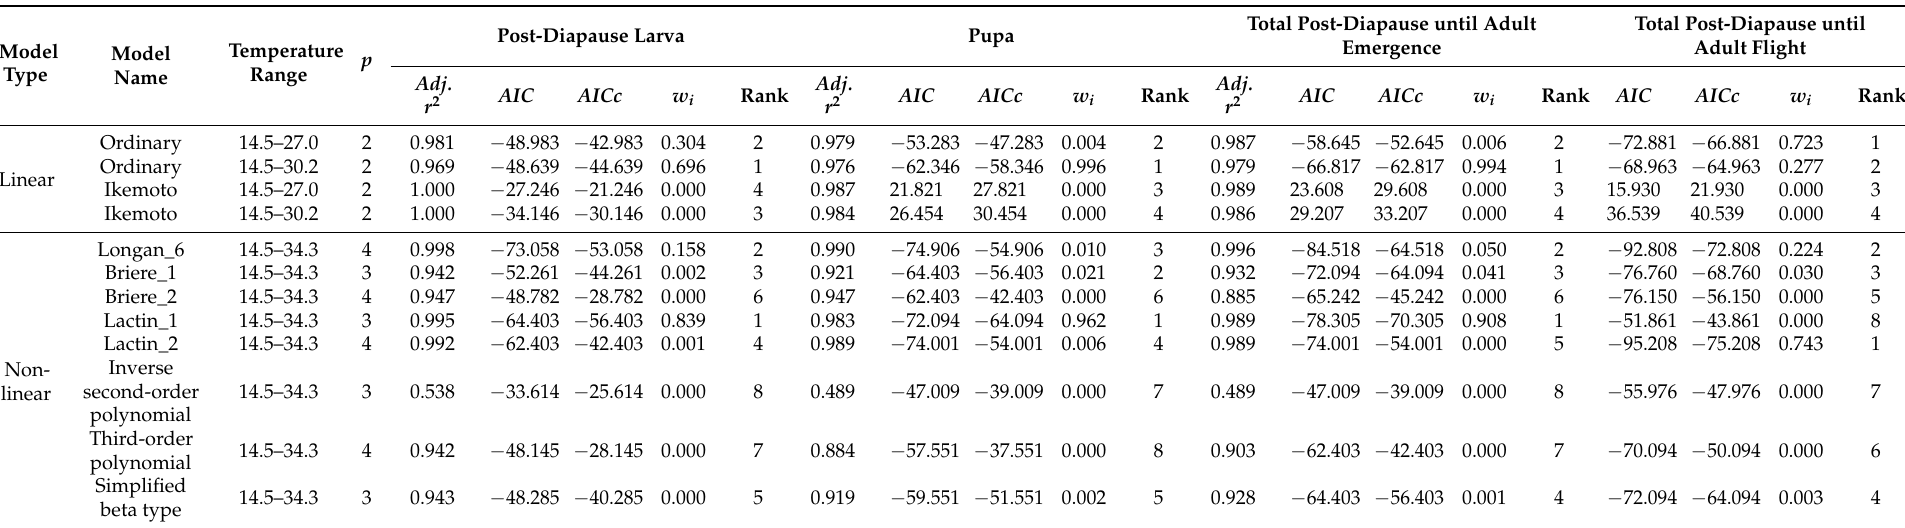
Table A1. Selection of linear and non-linear models for describing the relationship between temperature and the development rate of the post diapause period of Eurytoma maslovskii based on the corrected Akaike Information Criterion ( AICc ), and Akaike weights ( w i